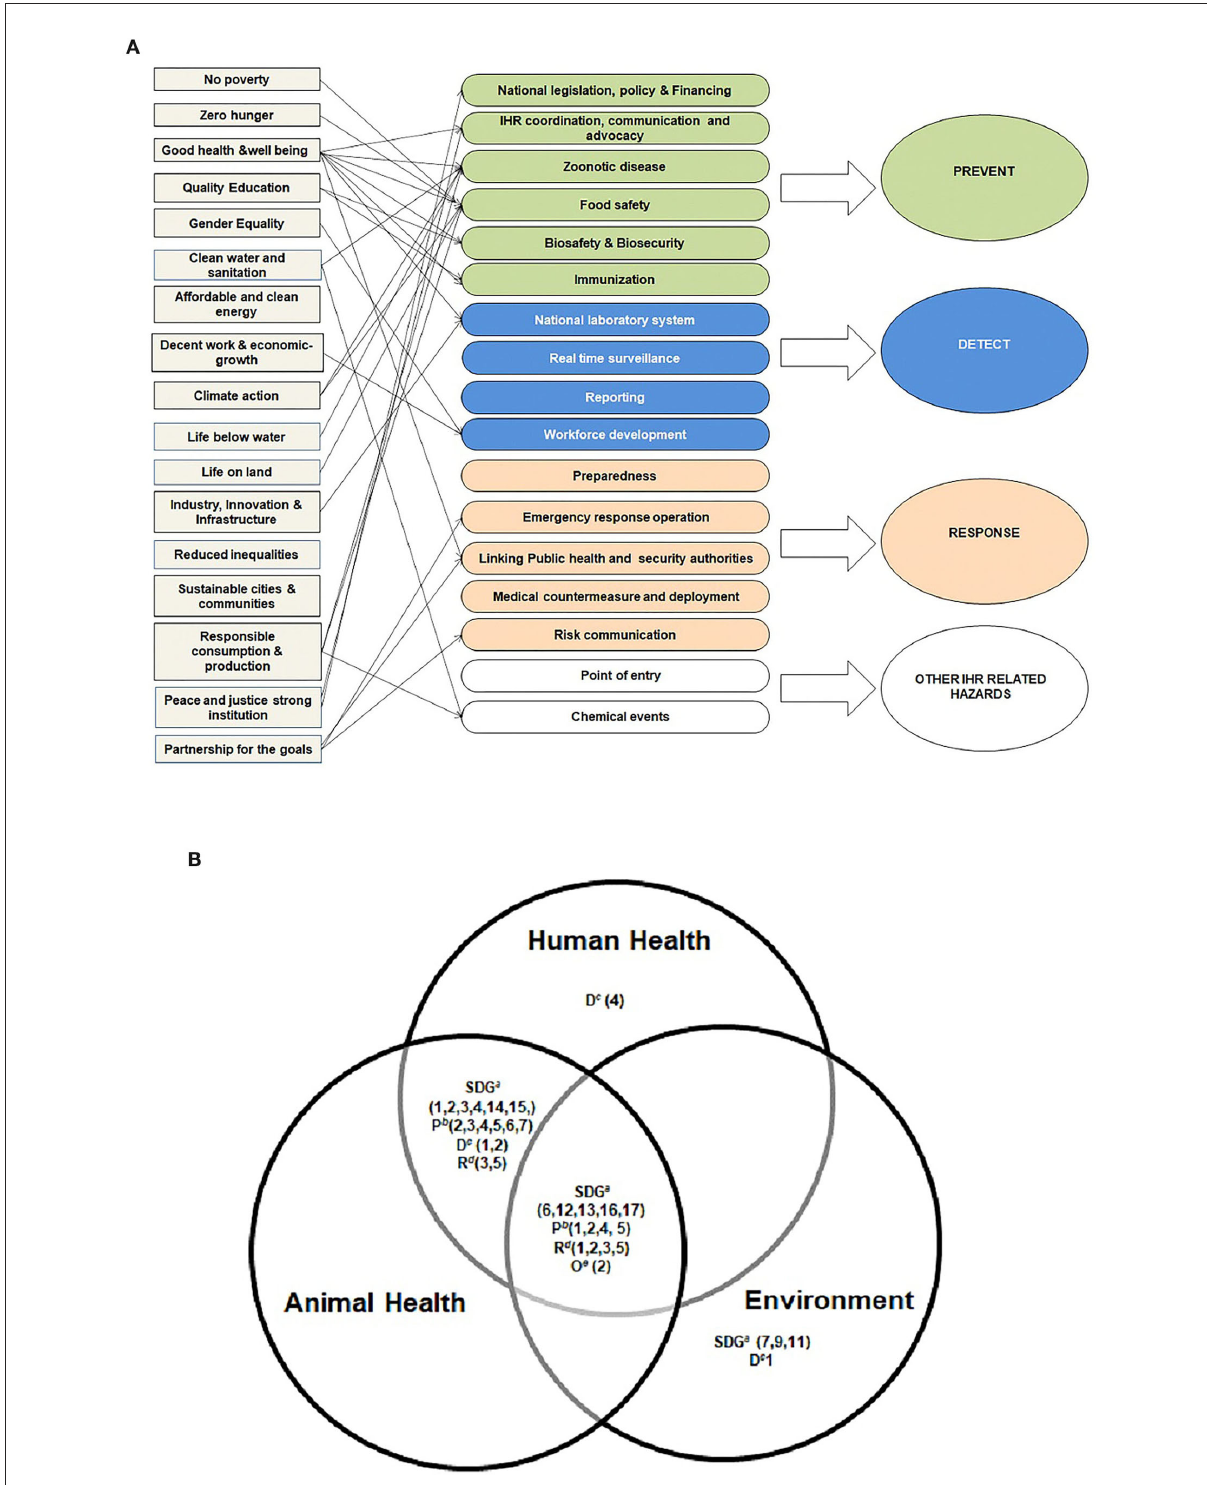
FIGURE1 (A) Cross-walk between 17 sustainable development goals and joint external evaluation categories, sustainable development goals, one health, India, 2019–2021. (B) Cross-walk showing linkage between sustainable development goals, joint external evaluation, and triad components of one health approach, sustainable development goals, one health, India, 2019–2021. a SDG denotes Sustainable Development Goals. b P denotes “prevent” category in joint external evaluation tool. c D denotes “detect” category in joint external evaluation tool. d R denotes “response” category in joint external evaluation tool. e O denotes “other IHR related hazards” category in joint external evaluation